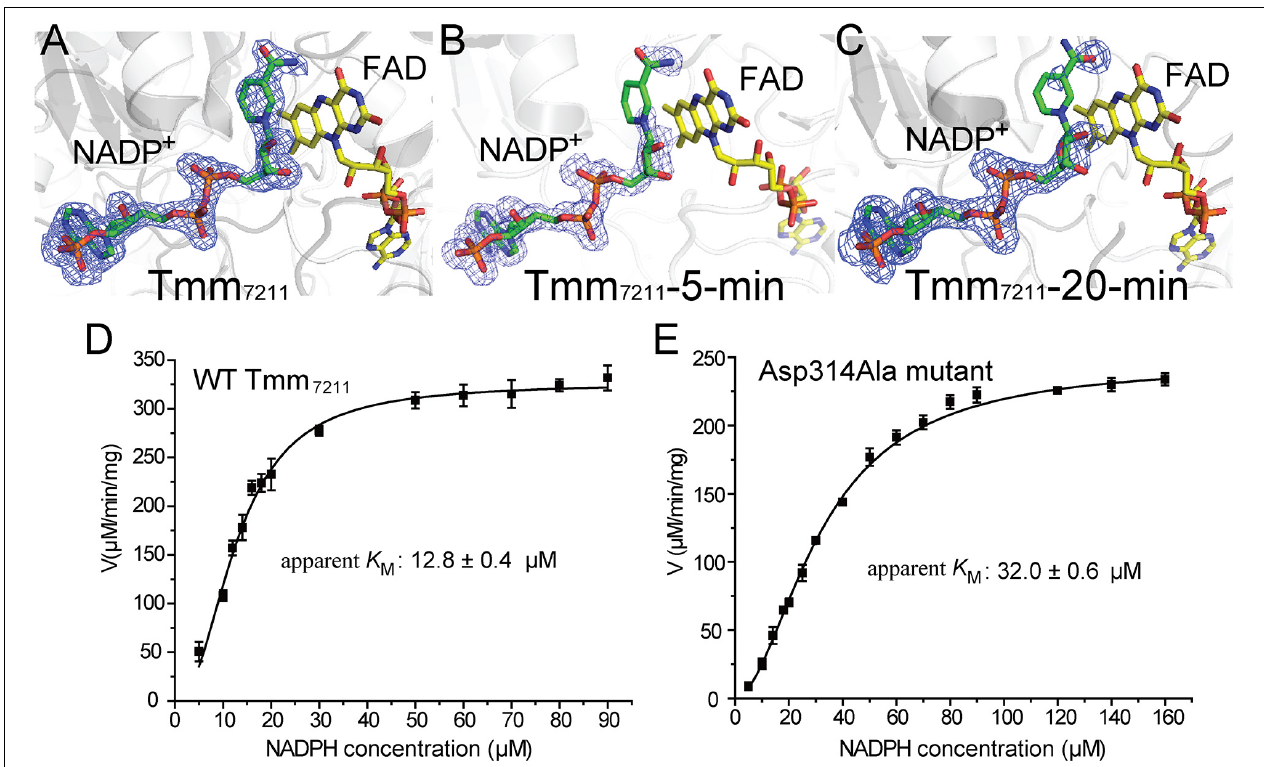
FIGURE 4 | Analysis of the conformational change of NADP + . (A) Structure of Tmm 7211 . (B) Structure of Tmm 7211 -5-min. (C) Structure of Tmm 7211 -20-min. The NADP + molecule and the FAD molecule are shown as sticks colored in green and yellow, respectively. The F o - F c densities for NADP + are contoured in blue meshes at 3.0 σ . (D) Kinetic analysis of WT Tmm 7211 toward NADPH. (E) Kinetic analysis of the mutant Asp314Ala toward NADPH.